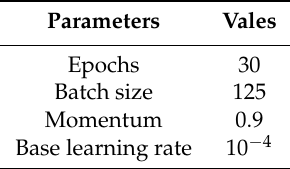
Table 2. Parameters setting for CNNs